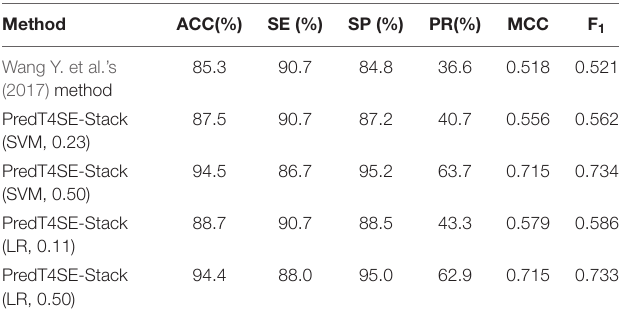
TABLE 4 | Performance comparison between our method with the other method on the independent dataset Test-850.